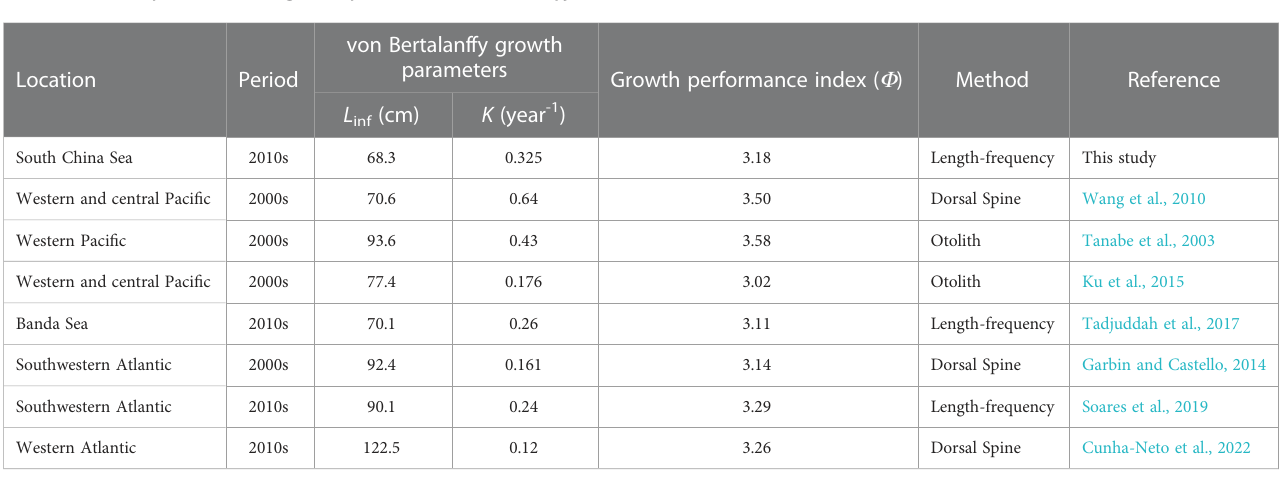
TABLE 2 Growth parameters and growth performance index of skipjack tuna stocks.